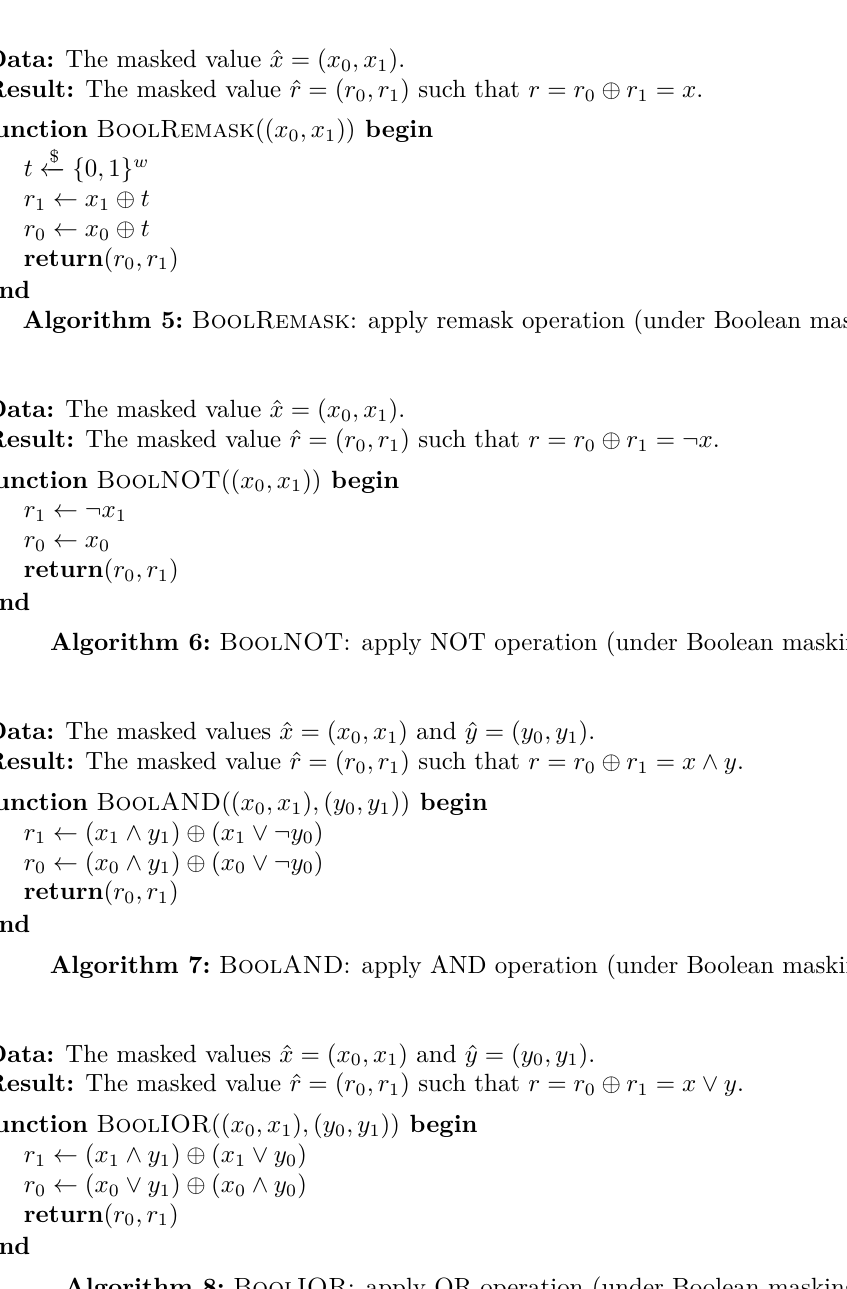
Algorithm 8: BoolIOR : apply OR operation (under Boolean